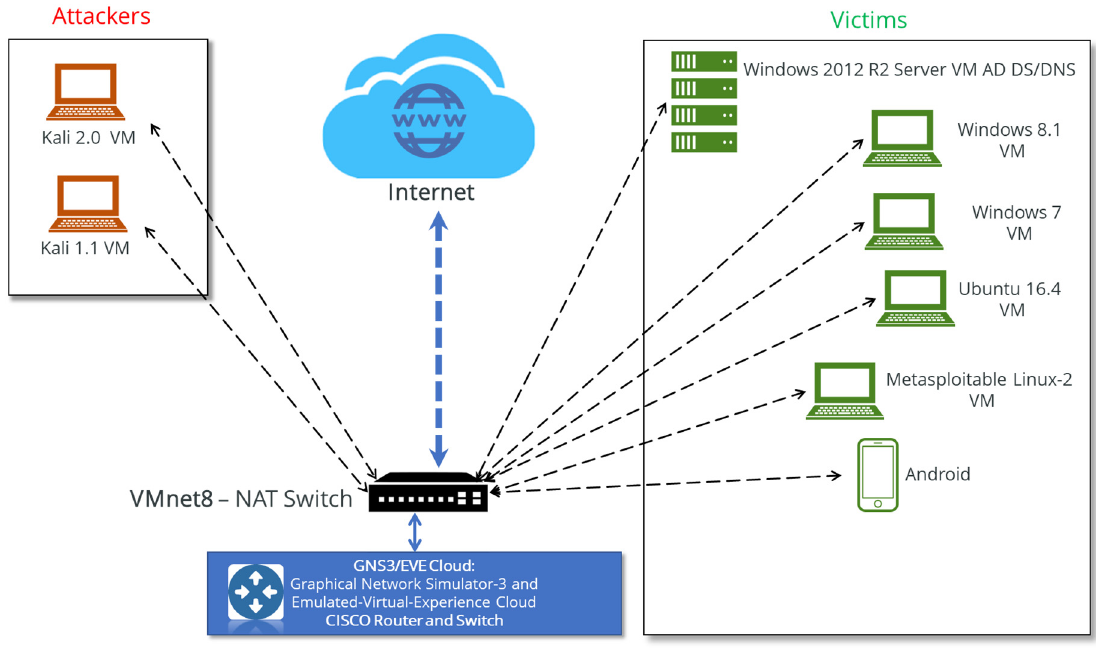
Figure 1. Testbed of GTCS dataset collection system.